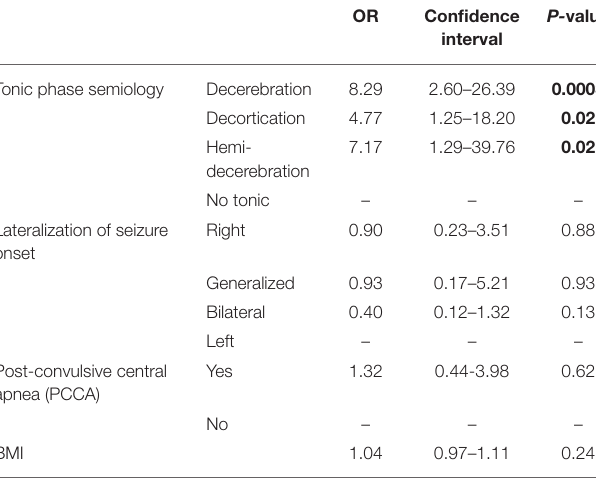
TABLE 2 | Seizure-specific electroclinical features and cardiorespiratory data of the patients.